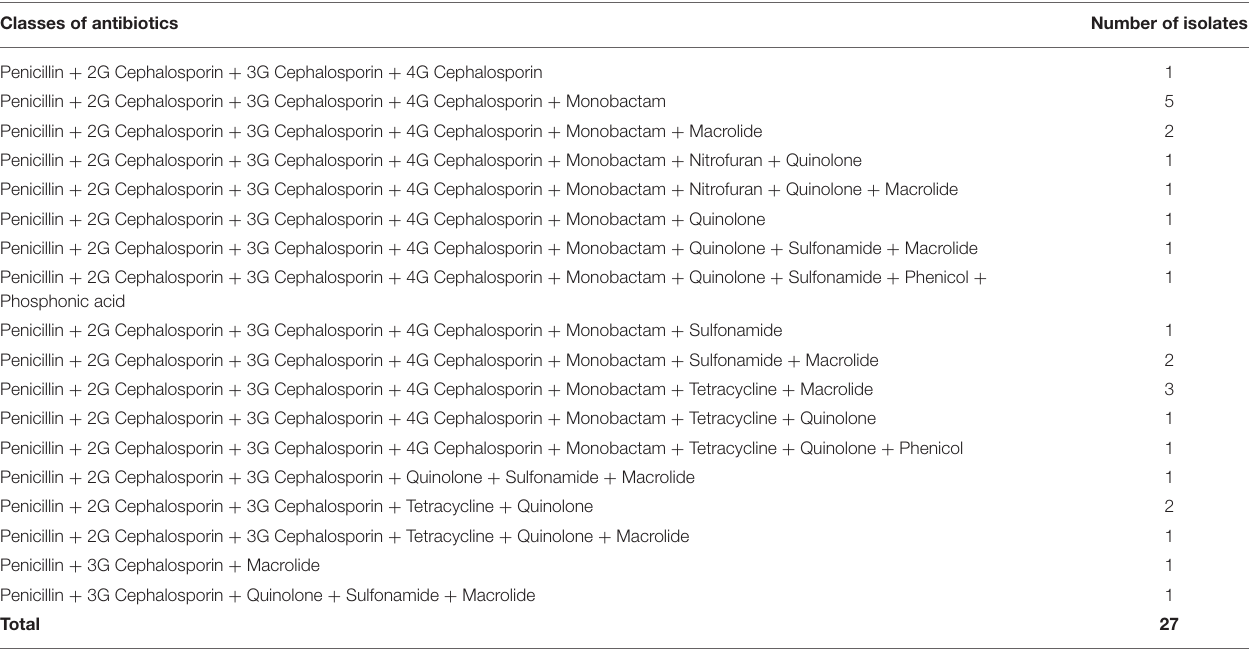
TABLE 2 | Number of isolates resistant to different classes of antibiotics. Classes of antibiotics Number of